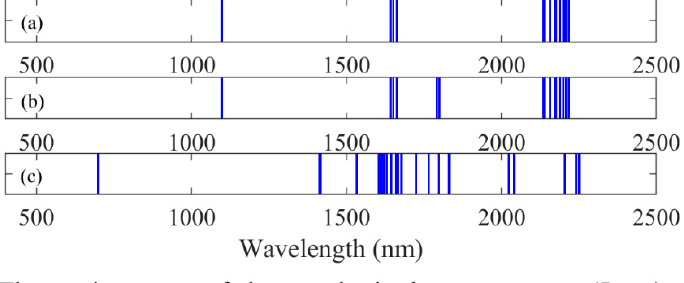
Figure 6. Correlation test between photosynthetic capacity and wavelength. The suffix ‘Der’ refers to the first-order derivative spectra, while the ‘Ref’ for the original reflectance, and the ‘psA’ for the apparent absorption spectra.